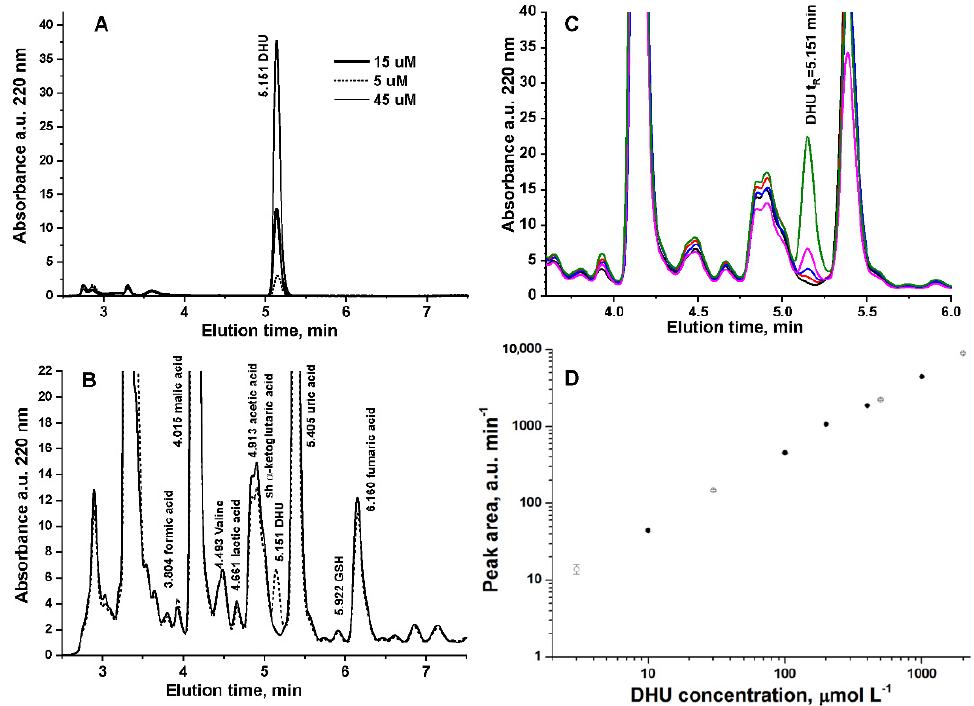
Figure 1. ( A ) Absorbance chromatogram at 220 nm of 5, 10, and 45 μ mol L − 1 DHU. ( B ) Absorbance chromatogram at 220 nm of unspiked saliva (continuous line) and spiked with 10 μ mol L − 1 DHU (dotted line). ( C ) Absorbance chromatogram at 220 nm of unspiked saliva (continuous line) and spiked with 1 (red line), 3 (blue line), 10 (magenta line), or 30 μ mol L − 1 DHU (green line). ( D ) External calibration curve (full circle) and calibration curve of DHU analytical standard added in saliva (open circle) ( N = 3 replicates).